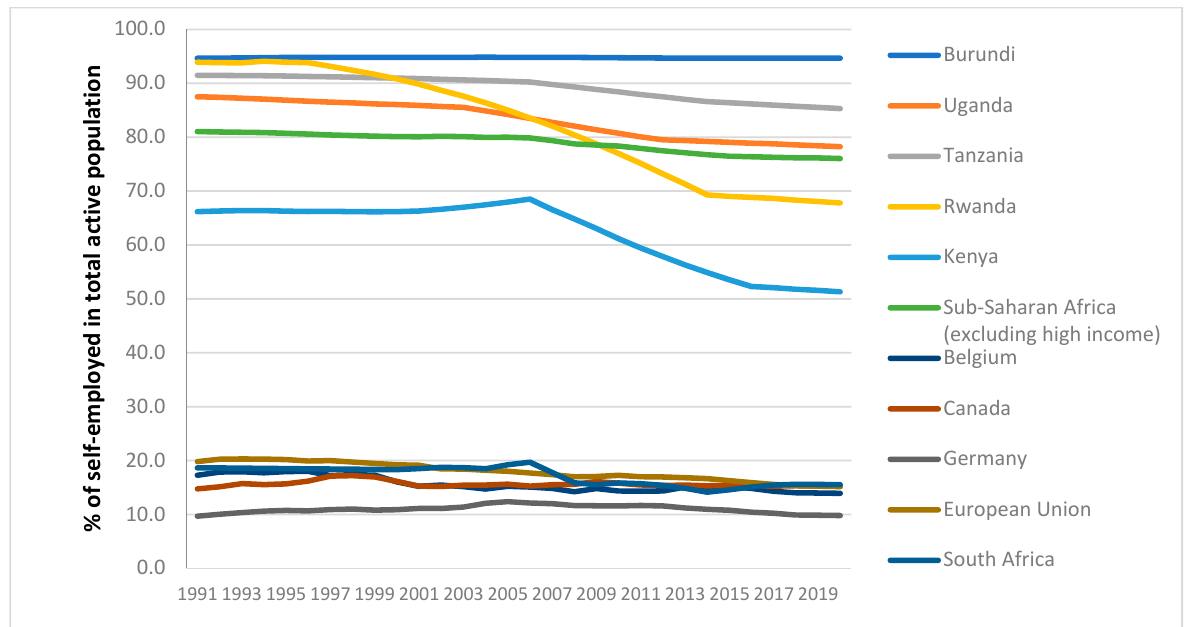
Figure 1. Cross-country self-employment in several industrial and non-industrial countries. Source: Authors from Open Data of the World Bank Group [18].